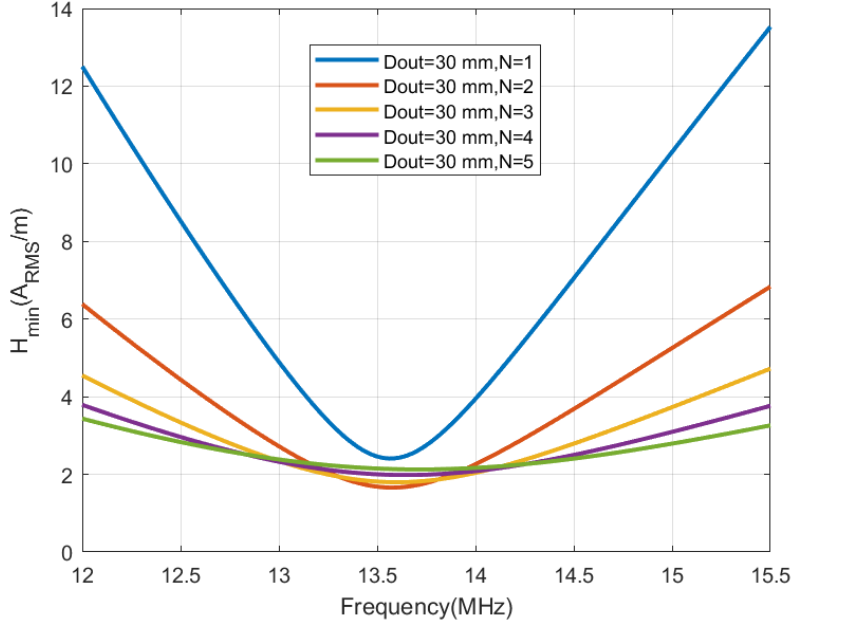
Figure 10. Simulated minimum magnetic field as a function of the frequency for a square antenna with outer diameter of 30 mm and a different number of